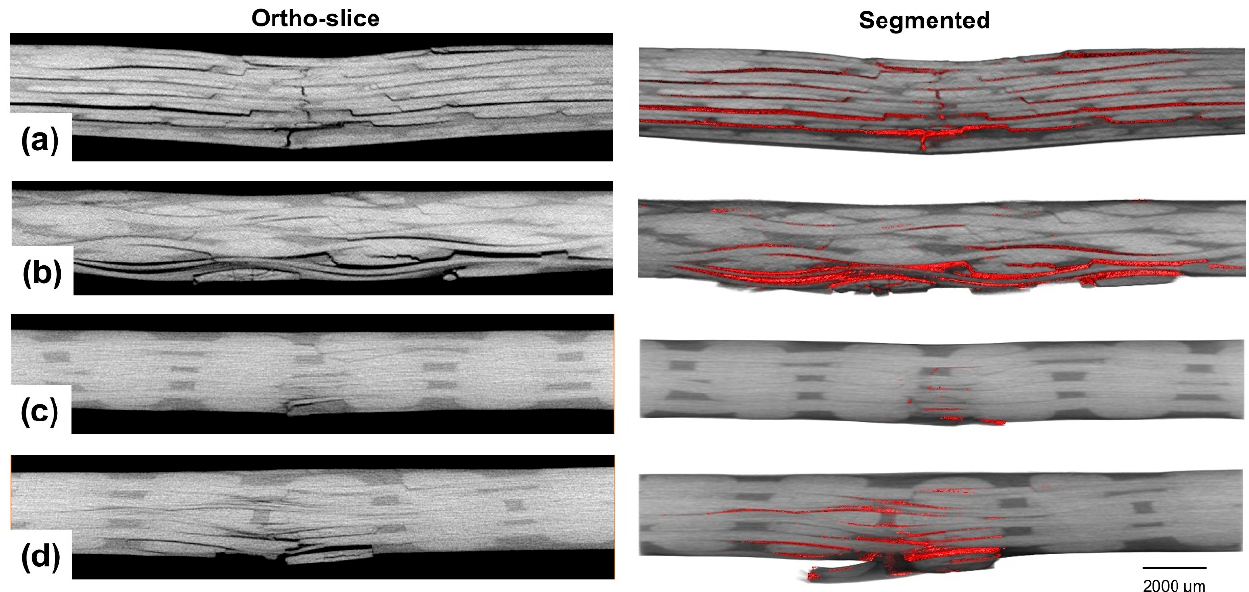
Figure 8. Ortho-slices and segmented damage highlighted in red in locations where there are no binding yarns (the top is the front side of the impact and the bottom is the backside) for: ( a ) NCF, ( b ) 2D-PW, ( c ) ORT-PW and ( d ) ORT-TW.